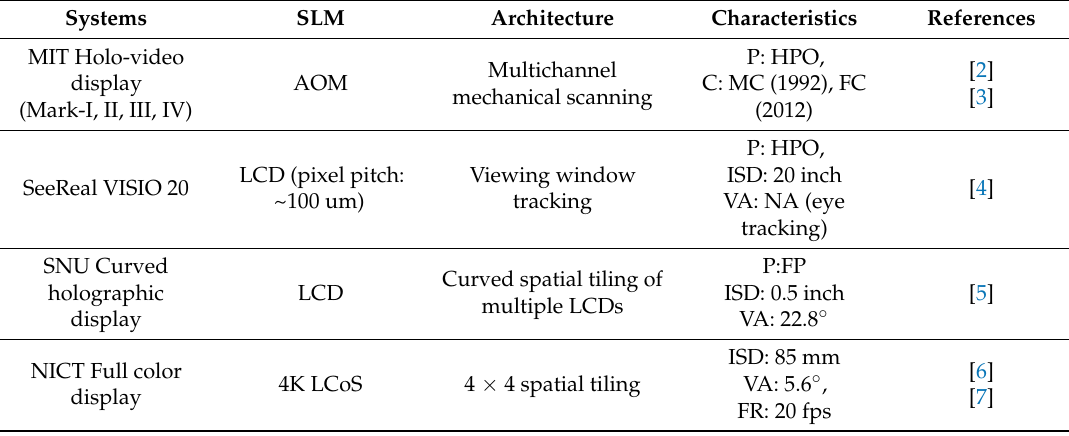
Table 1. Electronic holographic display